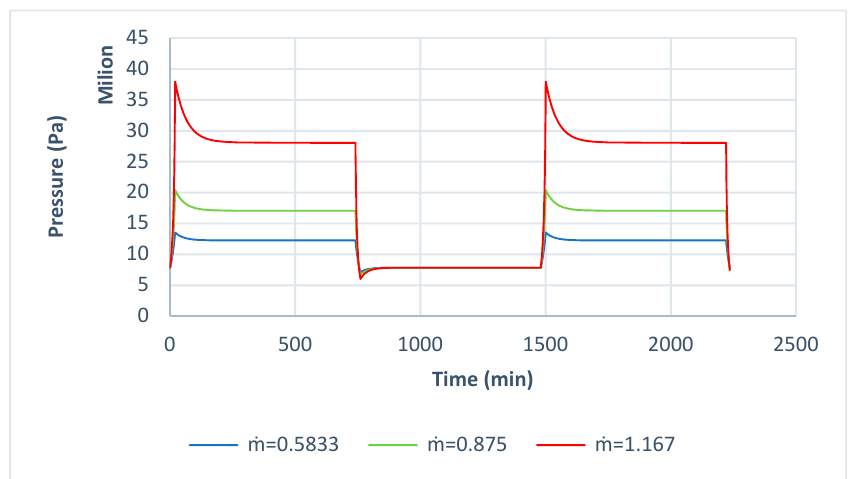
Figure 5. Gas temperature trend for the Second Configuration varying the liquid flow rate.